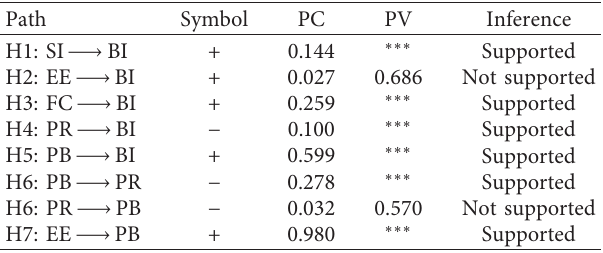
Table 6: Test results of the proposed hypotheses. Table 7: Effect values between latent